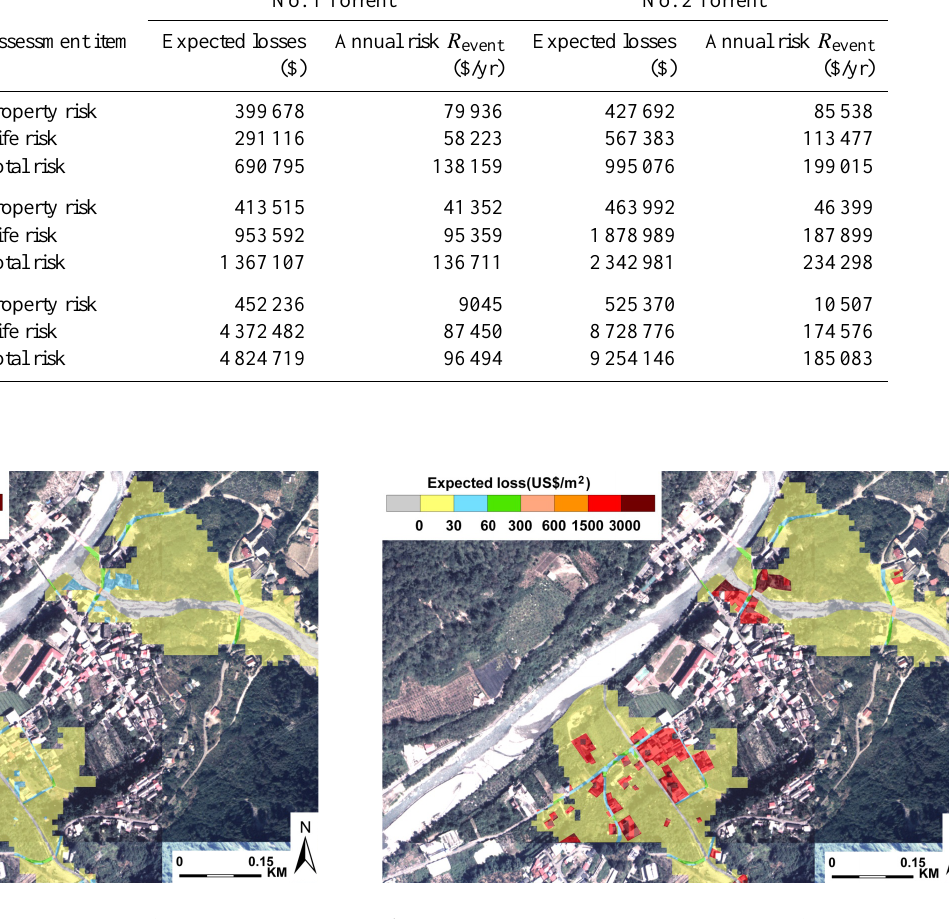
Fig. 5. Map showing the spatial distribution of expected total loss caused by debris flows of the Nos. 1 and 2 Torrents for an event with 50-year return period.